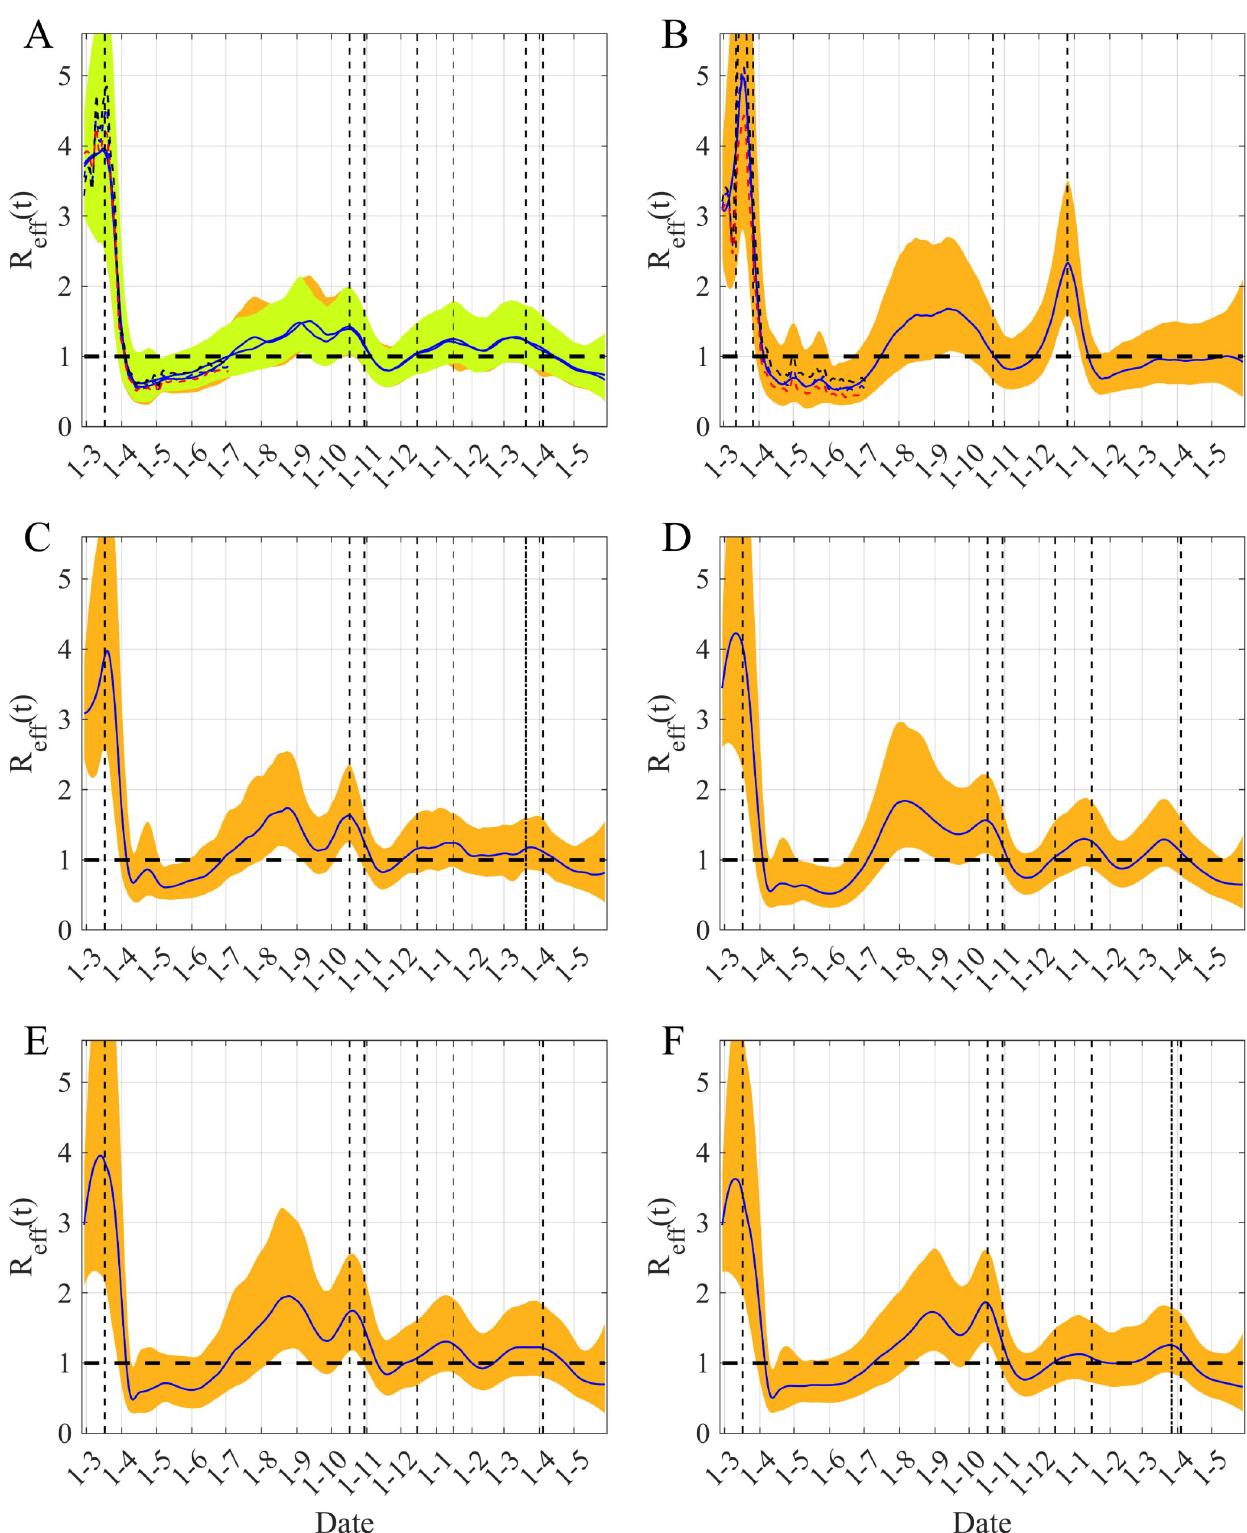
Fig 4. Time varying R eff (t) in five regions of France and in Ireland. (A) Ile-de-France, (B) Ireland, (C) Provence Alpes Coˆte d’Azur, (D) Occitanie, (E) Nouvelle Aquitaine (F) Auvergne Rhoˆne Alpes. The blue lines are the median of the posterior estimates of R